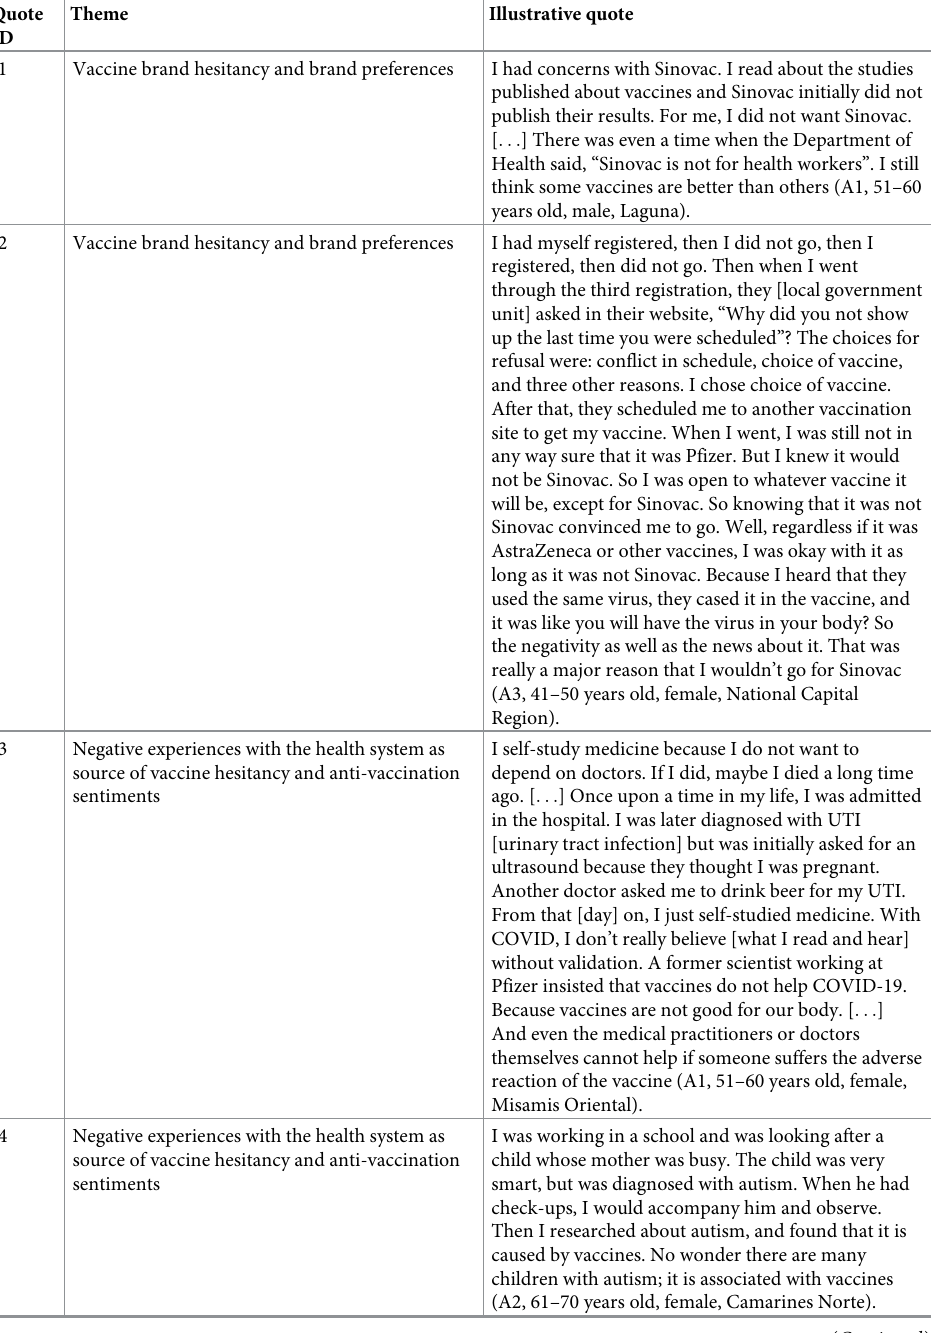
Table 3. Illustrative quotes for individual